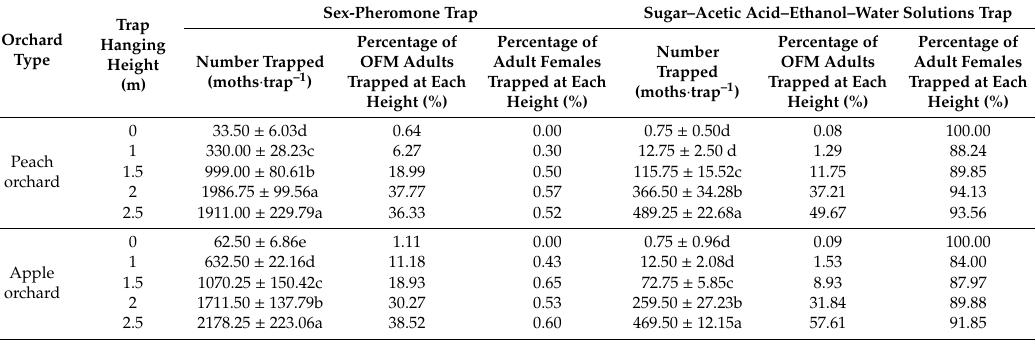
Table 1. Trapping e ffi cacy for female / male ratio of OFM adults by sex-pheromone-baited and Sugar–acetic acid–ethanol–water mixture (SAEWM)-baited traps hung at di ff erent heights in Tai’an, China, in 2016.